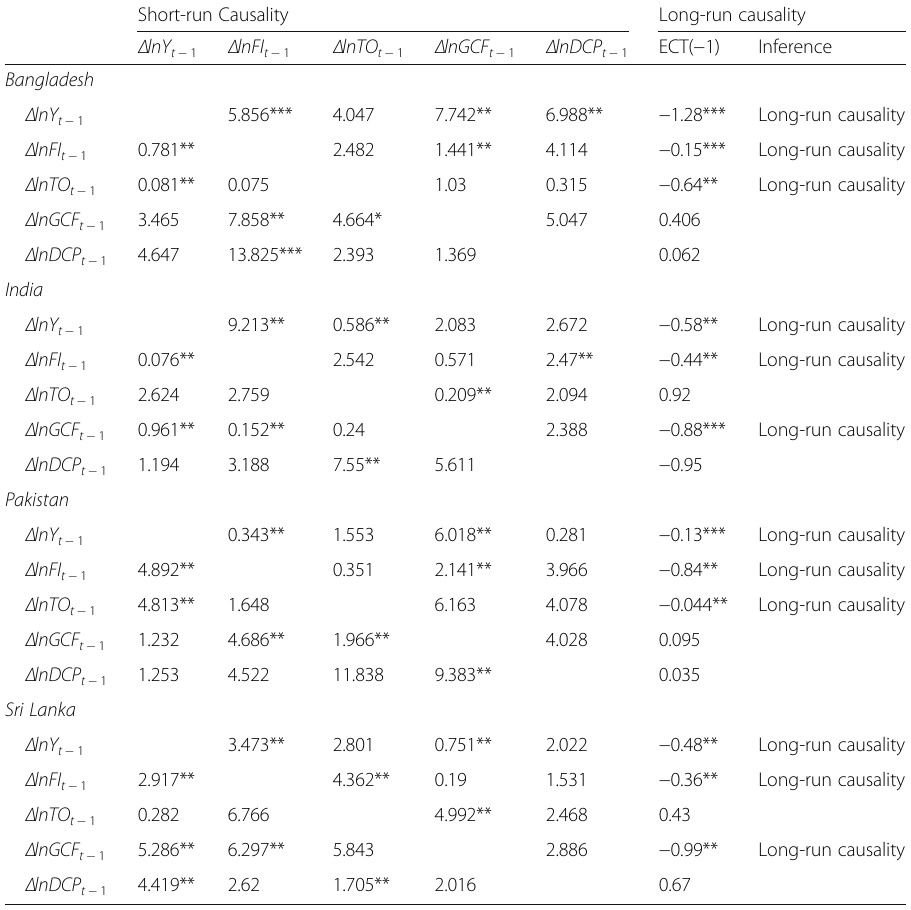
Table 6 Granger-causality results Short-run